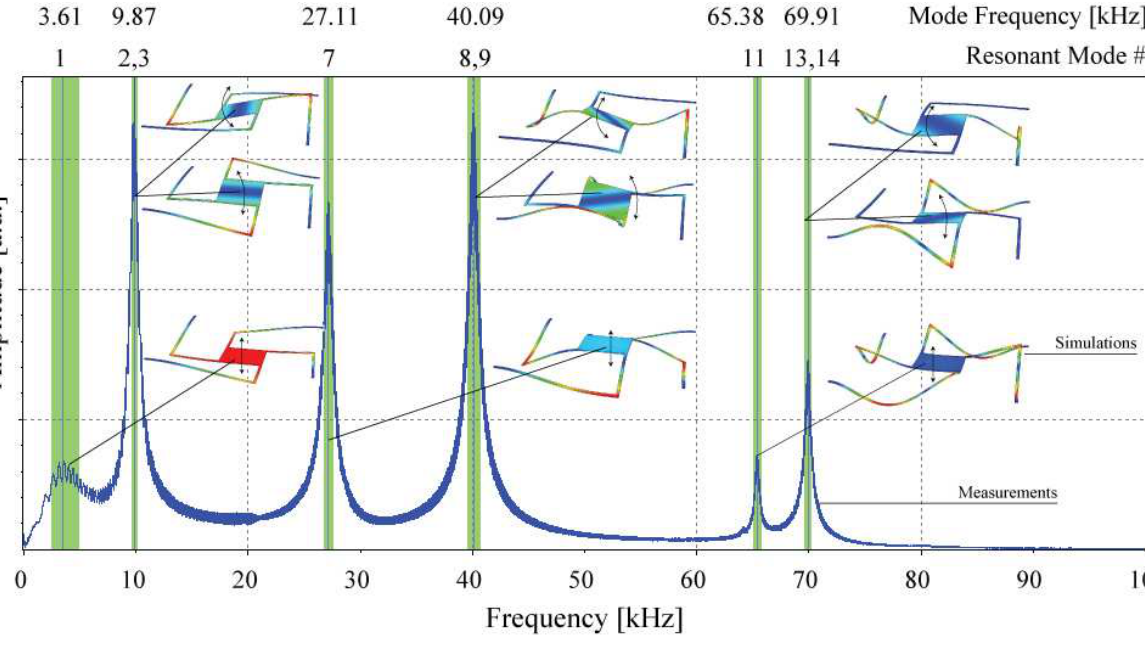
Figure 5: Measurements of the mirror resonance frequencies and schematic representation of the different resonance modes obtained from the Finite Element Model frequency analysis. The modes which are not represented were not measured as their movement lies in the mirror